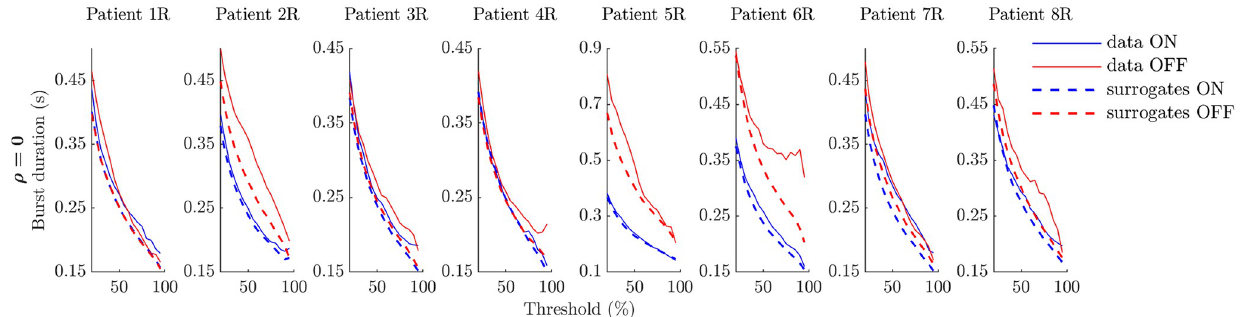
Fig 4. Average burst duration profiles ON and OFF medication for data and GWR surrogates at ρ = 0 (right hemispheres). In all panels, data profiles are solid lines, while linear surrogate profiles are dashed lines. The OFF medication state is indicated in red, and the ON state in blue.